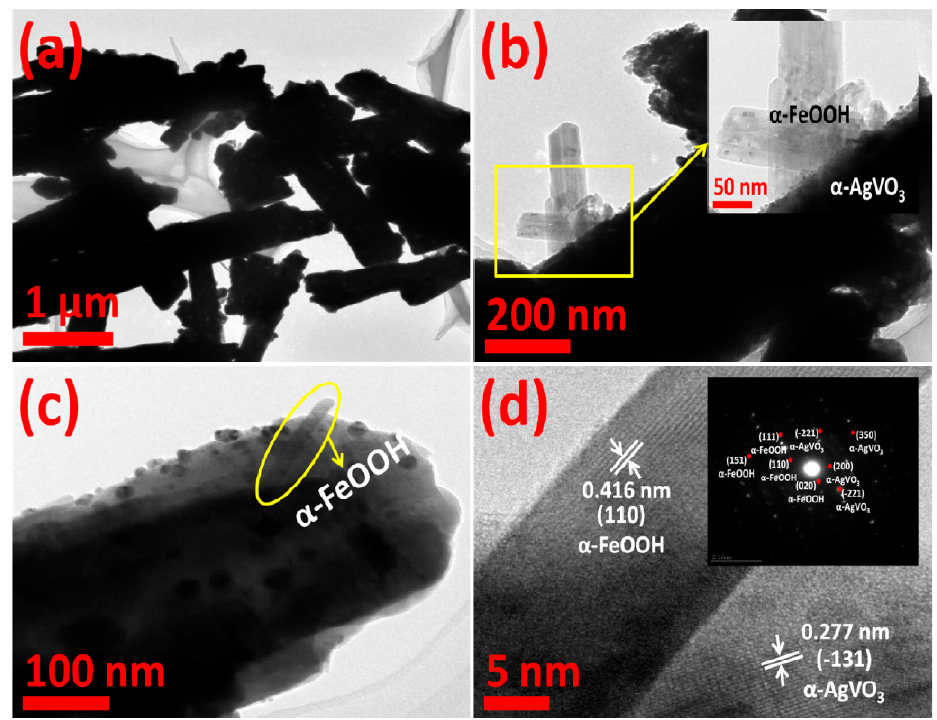
Figure 5. ( a – d ) High-resolution transmission electron microscopy (HR-TEM) images of the optimized FeAVO-3 nanocomposite photocatalyst at different magnifications with the corresponding selected area (electron) diffraction (SAED) pattern.